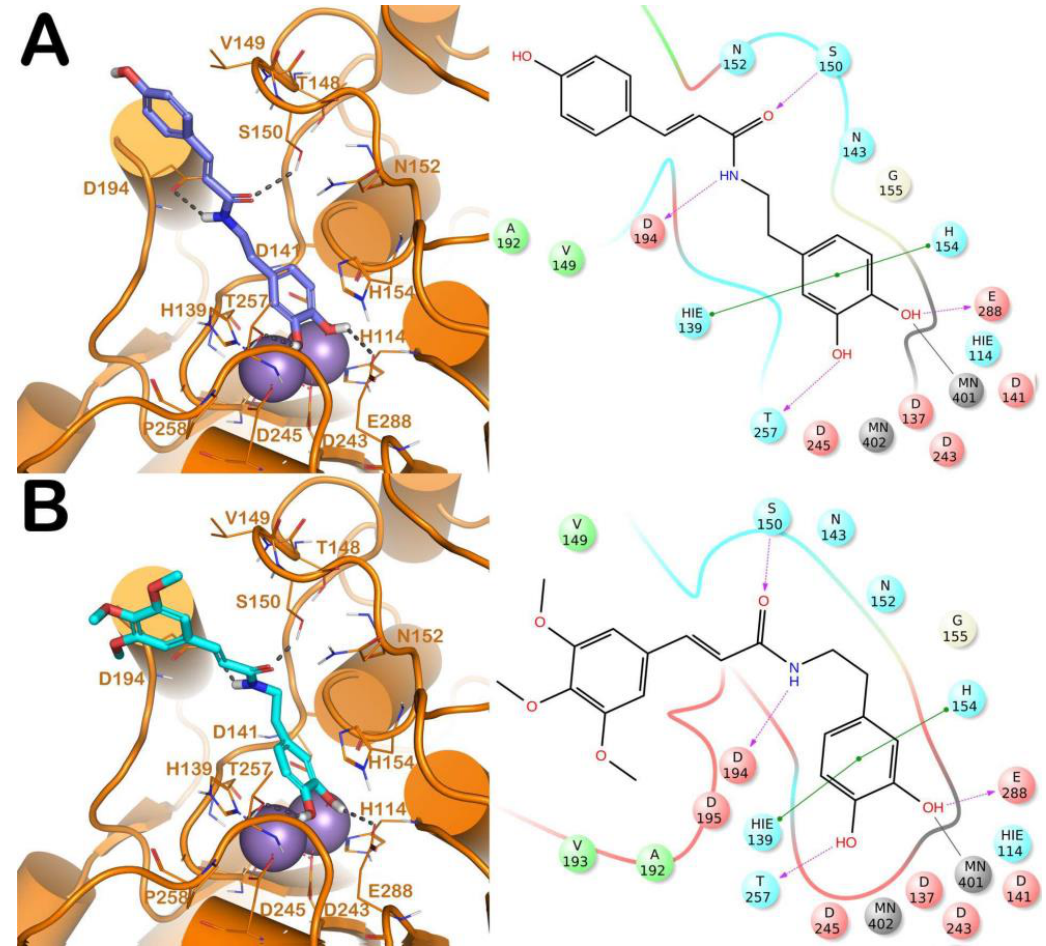
Figure 2. ( A ) Putative binding mode of compound 13 (blue sticks) into L-ARG binding site (PDB ID 4IU1; orange cartoon) as found by Glide software. Metals are represented as gray spheres. Key residues of the binding site are represented by lines. H-bonds are represented as black dotted lines, while the metal coordination bonds are represented by colored dotted lines. The ligand interaction diagram is reported on the right panel. ( B ) Putative binding mode of compound 14 (cyan sticks) into L-ARG binding site (PDB ID 4IU1; orange cartoon) as found by Glide software. Metals are represented as gray spheres. Key residues of the binding site are represented by lines. H-bonds are represented as black dotted lines, while the metal coordination bonds are represented by colored dotted lines. The picture was generated by PyMOL (The PyMOL Molecular Graphics System, v1.8; Schrodinger, LLC, New York, NY, USA, 2015), while the ligand interaction diagram was generated by Maestro (Maestro, Schrödinger, LLC, New York, NY, USA, 2016).